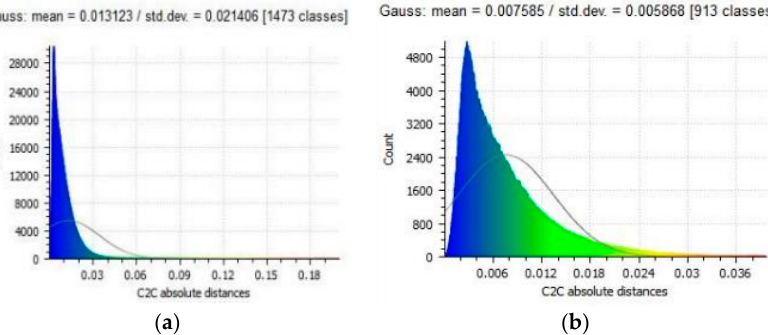
Figure 12. Extension of point clouds, UAV data coloured in blue, ZEB data in orange: ( a ) angular view of the external walls with the presence of vegetation and ( b ) vertical section of the Rocca.